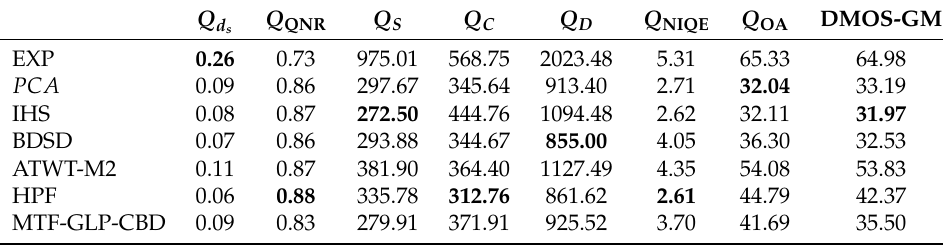
Table 11. IKONOS Roma Road scene, full-resolution, image quality assessment metrics, and DMOS GM quantitative results. The bold number indicates the best performing PS method according to each quality metric.